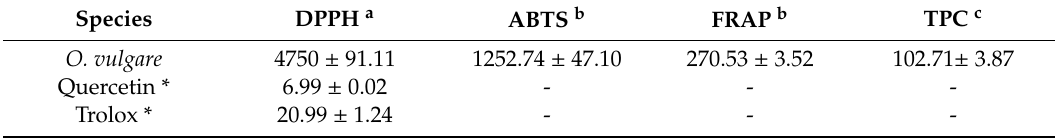
Table 3. Antioxidant activity of Origanum vulgare essential oil from Putre, Chile.